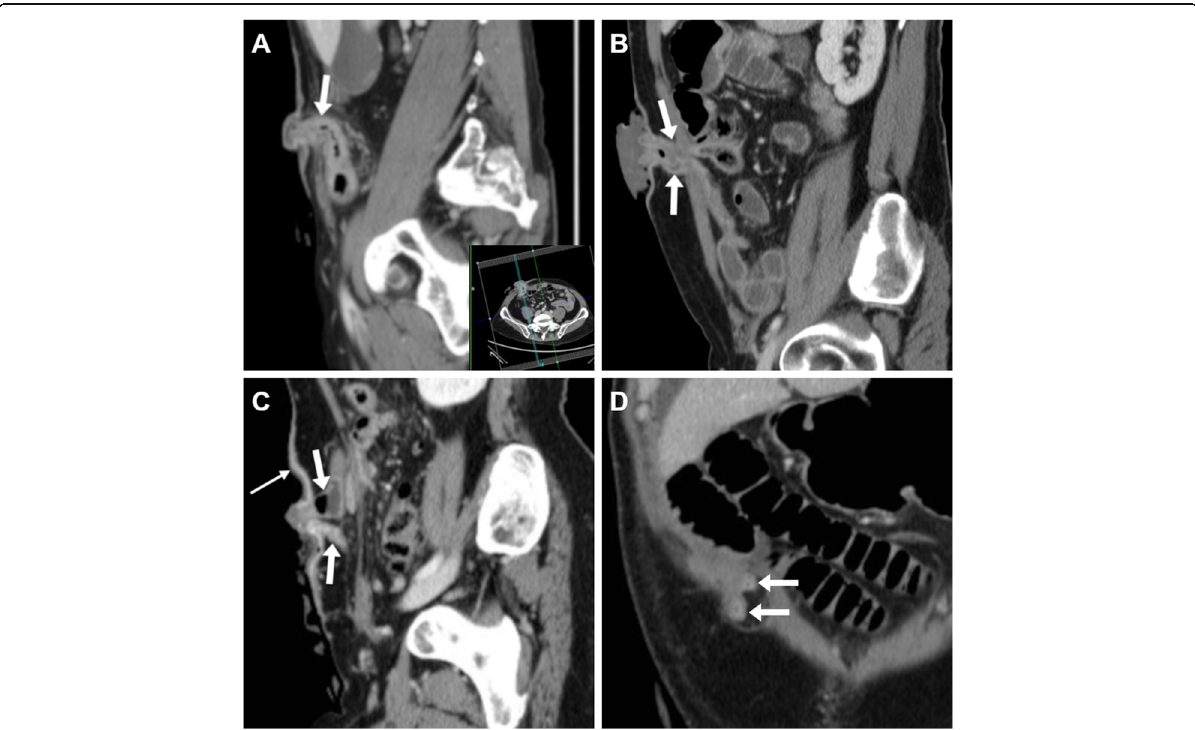
Fig. 5 CT reconstruction technique and expected findings of ileostomies. a Focused oblique-sagittal (note lateral obliquity in inset) image of a normal end ileostomy with uniform mural thickness and enhancement of the stomal tract (arrow), mild protrusion at external orifice. b oblique- sagittal images of a loop ileostomy identify non-thickened, collapsed efferent and afferent limbs (arrows). Note fluid flowing at the external orifice indicating stomal patency. c , d A typical defunctioning loop ileostomy with two limbs (arrows) on sagittal ( c ) viewing and coronal ( d ) appearance. Note mild thickening and hyperenhancement of peristomal skin in c (compared to a and b ) consistent with cutaneous inflammation at physical